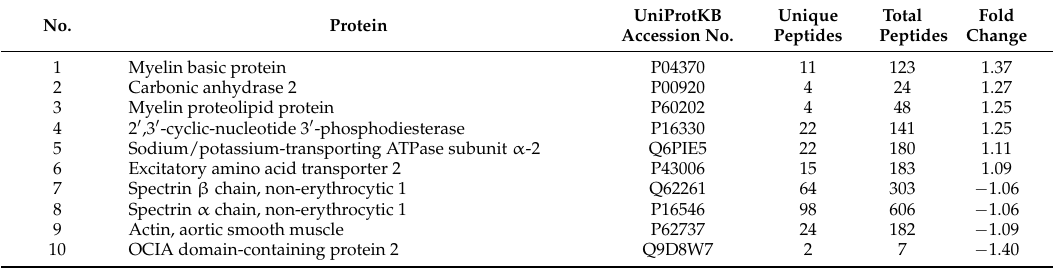
Table 6. Differentially expressed proteins in the hippocampus mitochondria of Alda-1-treated apoE − / − group vs. untreated apoE − / − group ( p < 0.05, n =